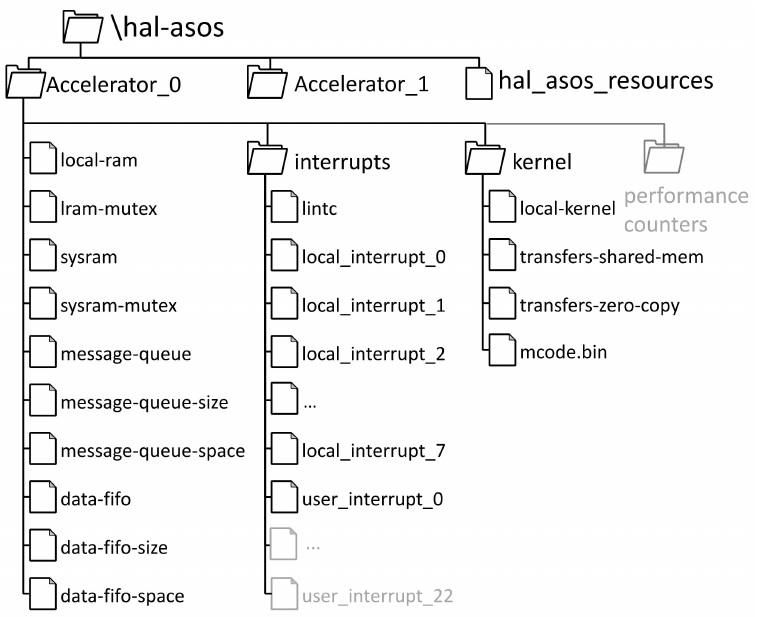
Figure 6. HAL-ASOS file system structure on